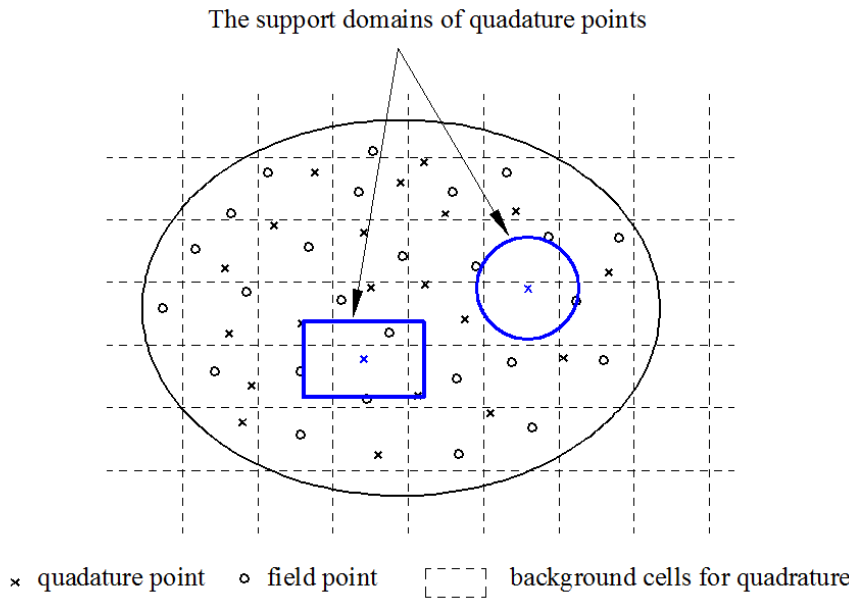
Figure 2. The description of constructed numerical approximation for the considered field function using the typical meshfree RPIM.